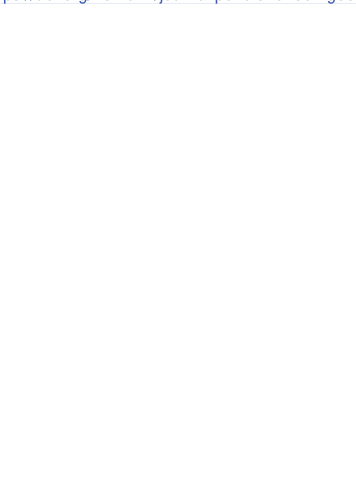
Fig 1. Distribution of bike share docks in NYC. (Data Sources: CitiBike Stations, NYC Parks, Census Blocks, NYC Neighborhood Names (S2 Table)).